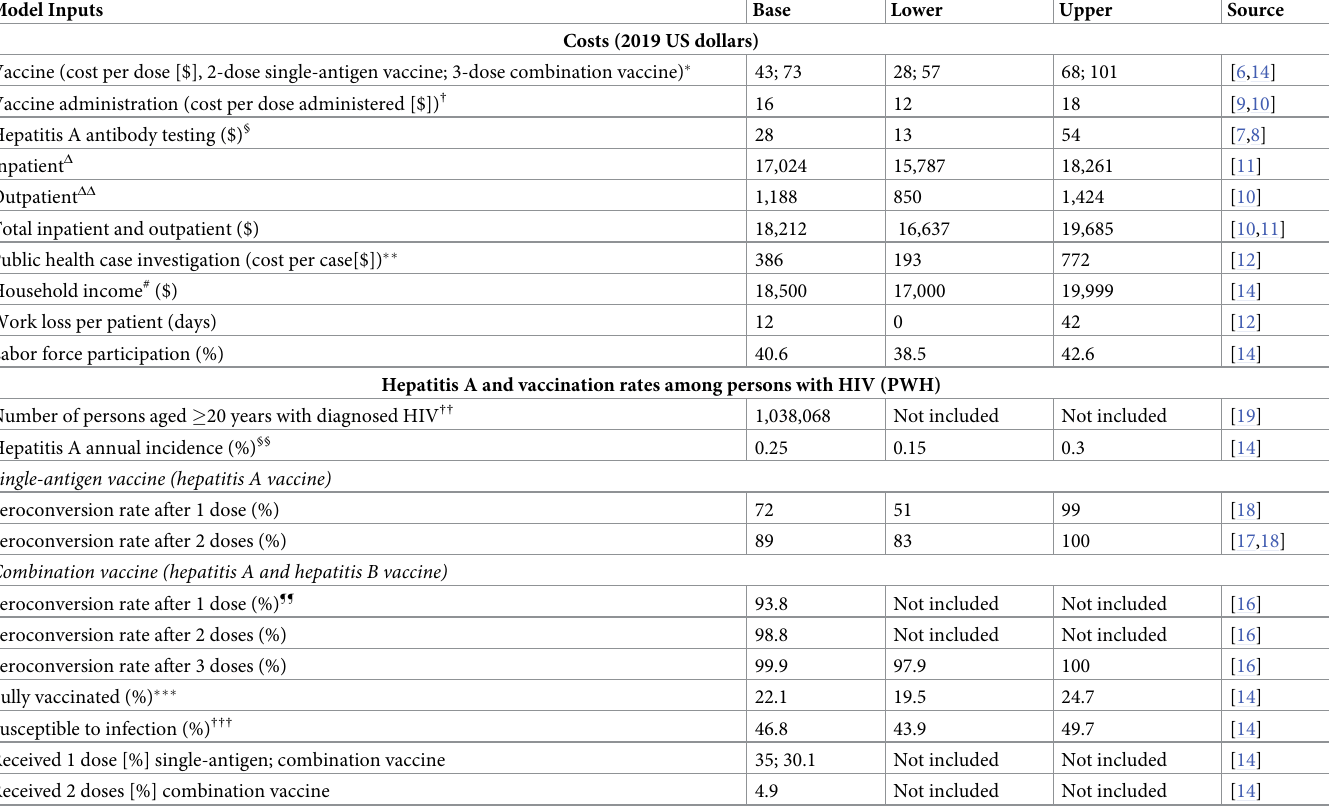
Table 1. Model inputs. Model Inputs Base Lower